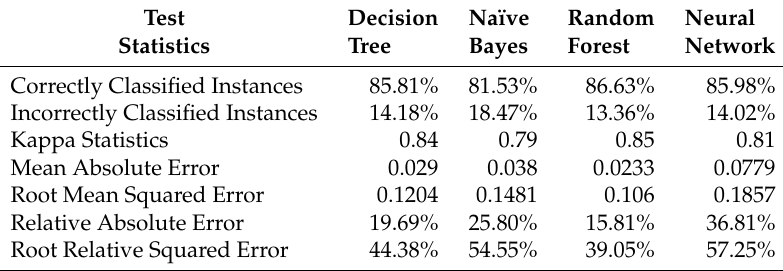
Table 4. Comparison of four different classifiers using statistical measures. The averages are for 10-fold cross-validation results of a 52 classes (diseases) classification.